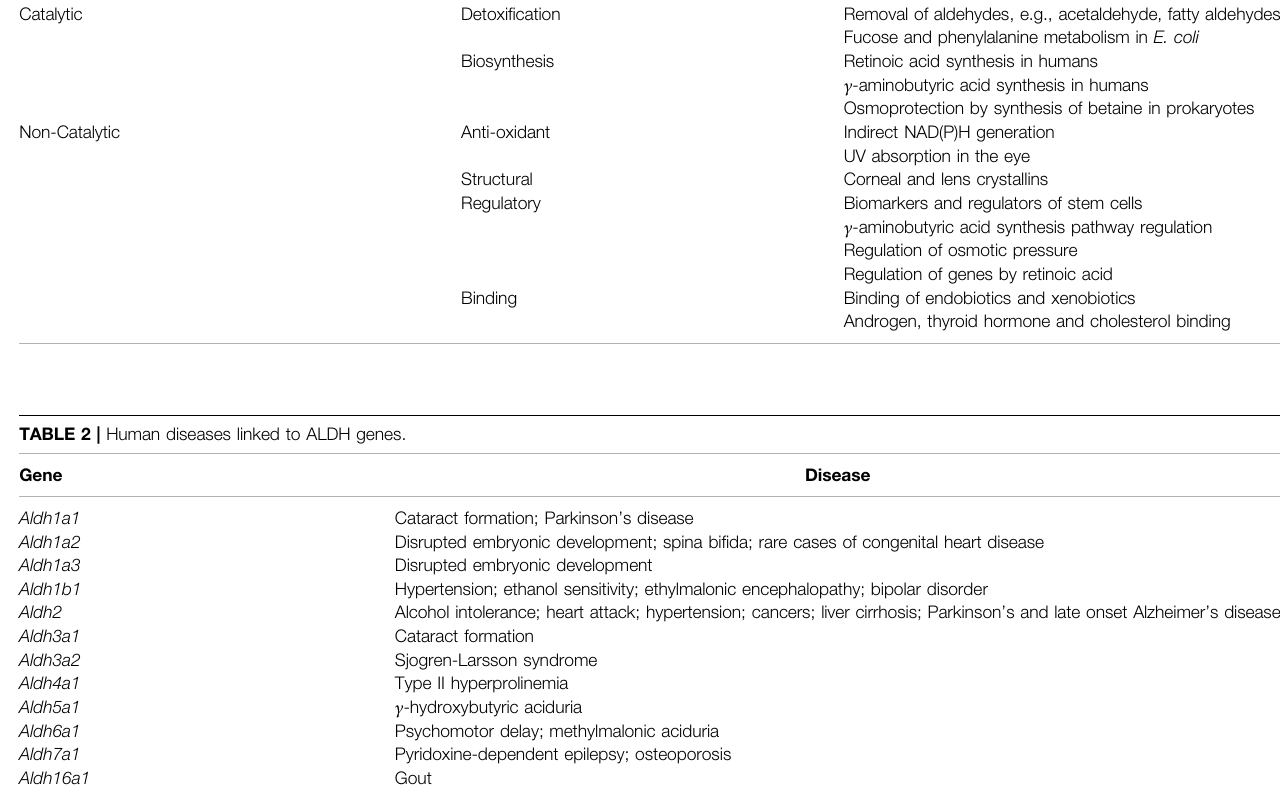
TABLE 1 | ALDH function, categorically highlighting examples of contribution to speci fi c mechanisms. Biological Function